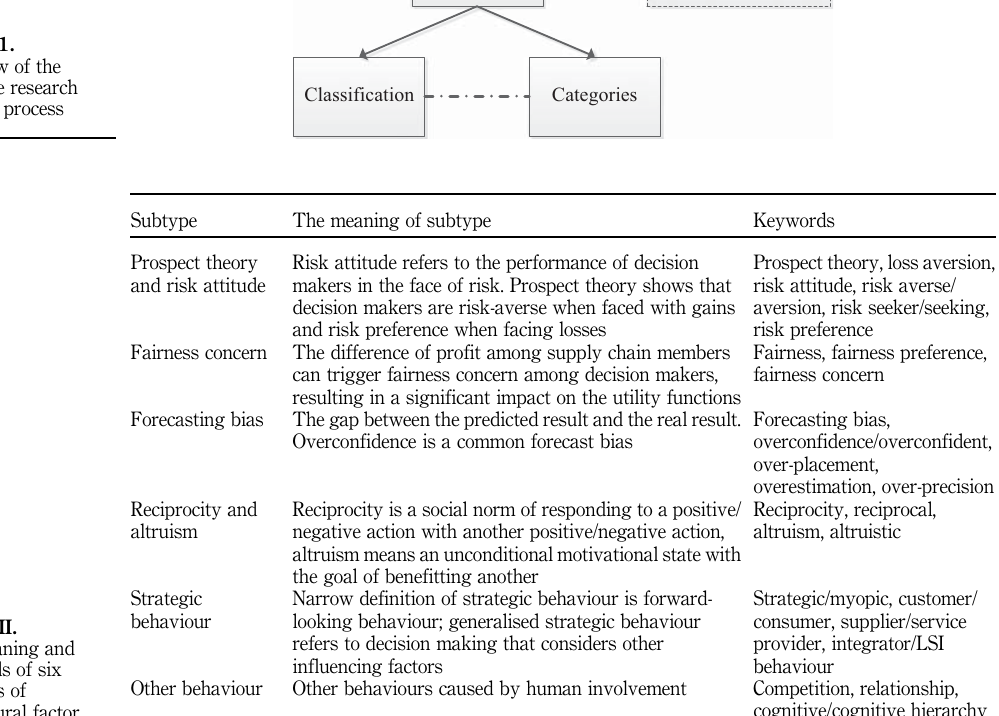
Figure 1. Overview of the